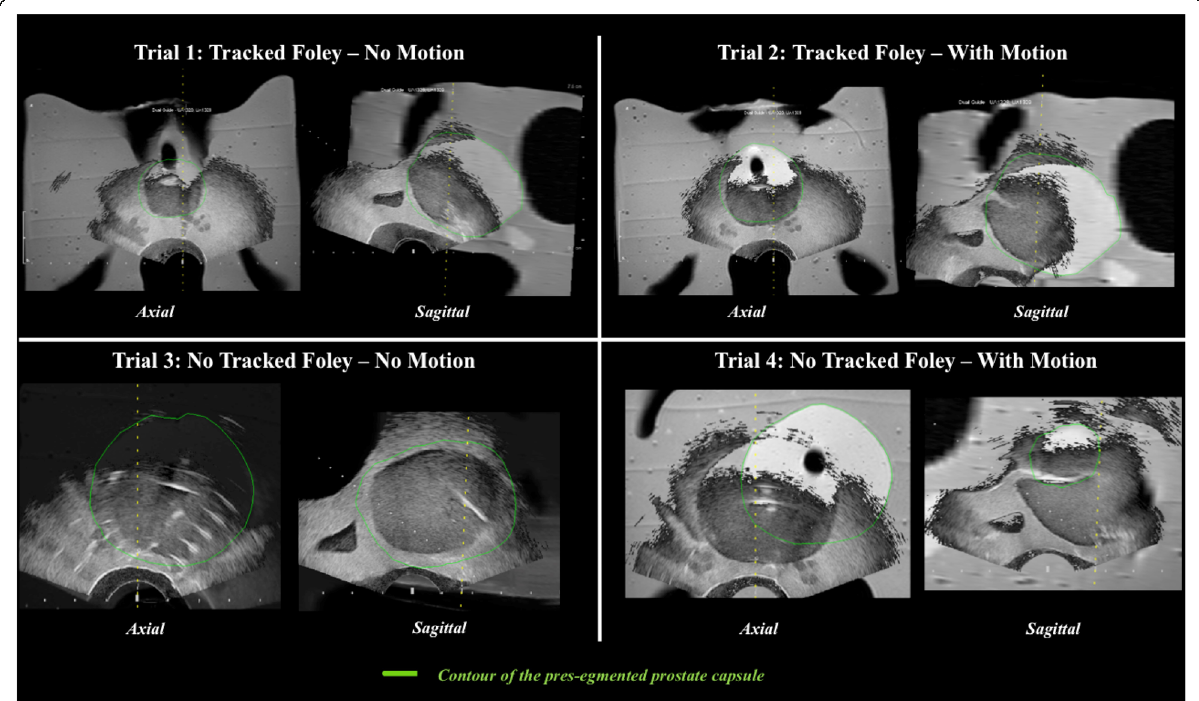
Fig. 6 Intra-experimental screen captures from trials 1 to 4: magnetic resonance imaging (MRI)/ultrasound (US) fusion images, displayed with variable windowing blending MRI and US. Note trial 3 images showing the US predominantly on the left and more MRI on the right. The green contour is the pre-segmented prostate capsule from the pre-procedural MRI